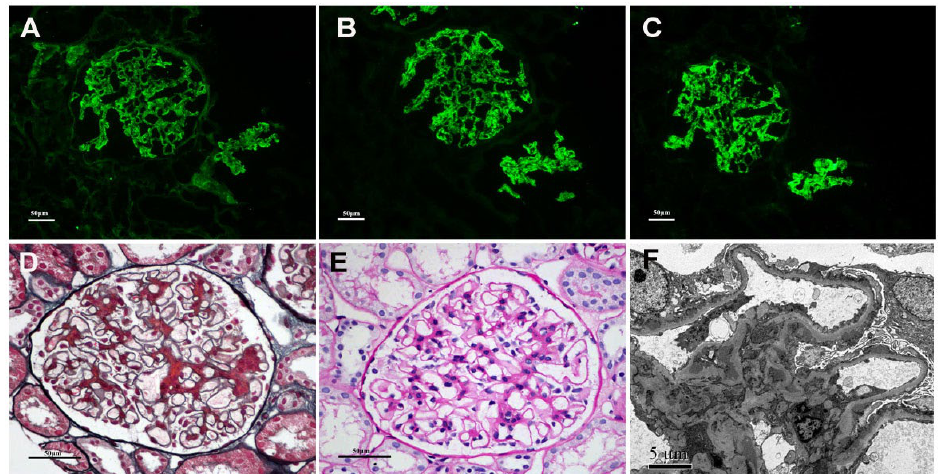
Figure 1. Renal biopsy findings for a PMN/IgAN patient. Immunofluorescence showing IgG ( A ) and IgG4 ( B ) in granular pattern. Immunofluorescence showing IgA ( C ) deposition in mesangial along with capillary area. Light microscopy showing glomerular basement membrane thickening and fuchsinophilic proteins in mesangial region ( D , E ). Electron micrograph showing subepithelial and mesangial electron-dense ( F ). ( A – C : Original magnification ×200; D , E : Original magnification ×400; F : Original magnification ×5000).